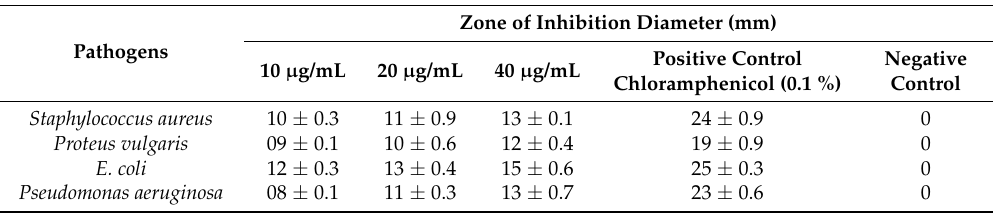
Table 1. Antibacterial activity of nickel oxide nanoparticles.